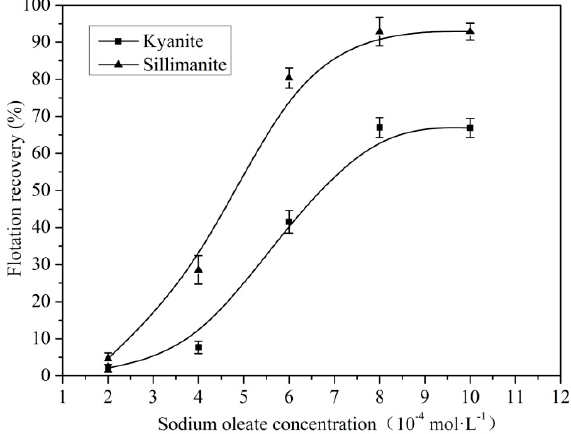
Figure 2. Flotation recovery of kyanite and sillimanite as a function of sodium oleate concentration at pH 8.0. Error bars represent mean values of three tests ± standard deviation.